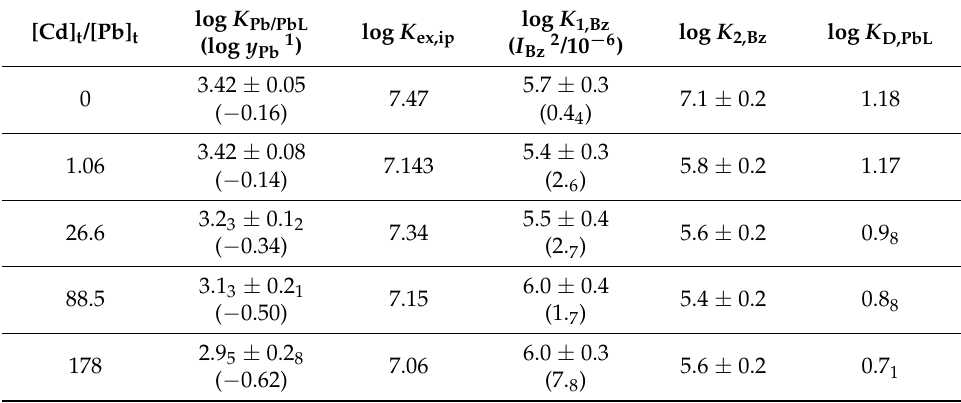
Table 2. Some equilibrium constants obtained from the Pb(II) extraction experiments by L = B18C6 from the water phase with co-presence of Cd(NO 3 ) 2 into Bz at 298